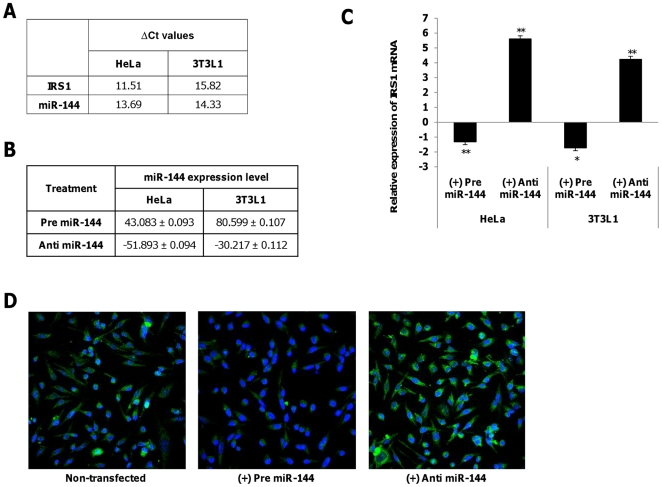
Expression of IRS1 in HeLa/3T3L1 cells transfected with pre- or anti- miR-144.
A.
 Endogenous levels of miR-144 and 
IRS1
 in HeLa/3T3L1 cells as delta threshold cycle (ΔCt) value with respect to 18S rRNA. Previous reports [42]–[44] have also confirmed that miR-144 and IRS1 are expressed in HeLa cells. B.
 Relative miR-144 expression in HeLa/3T3L1 cells transfected with either pre- or anti- miR-144 at a concentration of 30 nM.
C.
 Relative 
IRS1
 mRNA expression in HeLa/3T3L1 cells transfected with either pre- or anti- miR-144at a concentration of 30 nM. Data presented as mean ± SEM (n = 3). Fold change below one are expressed as the negative values. Statistically significant differences are tested at p<0.05 significance. *p<0.05, **p<0.01, ***p<0.001. D.
 IRS1 immunoreactives in HeLa cells transfected with either pre- or anti- miR-144. The cells were fixed and immunolabeled with IRS1 antibody (green) and nuclear stain DAPI (blue). Left panel: Non-transfected cells; Middle panel: Pre miR-144 transfected cells showed reduced fluorescence intensity; Right panel: Anti miR-144 transfected cells showed increased fluorescence intensity. The data presented here is a representative of three independent experiments.